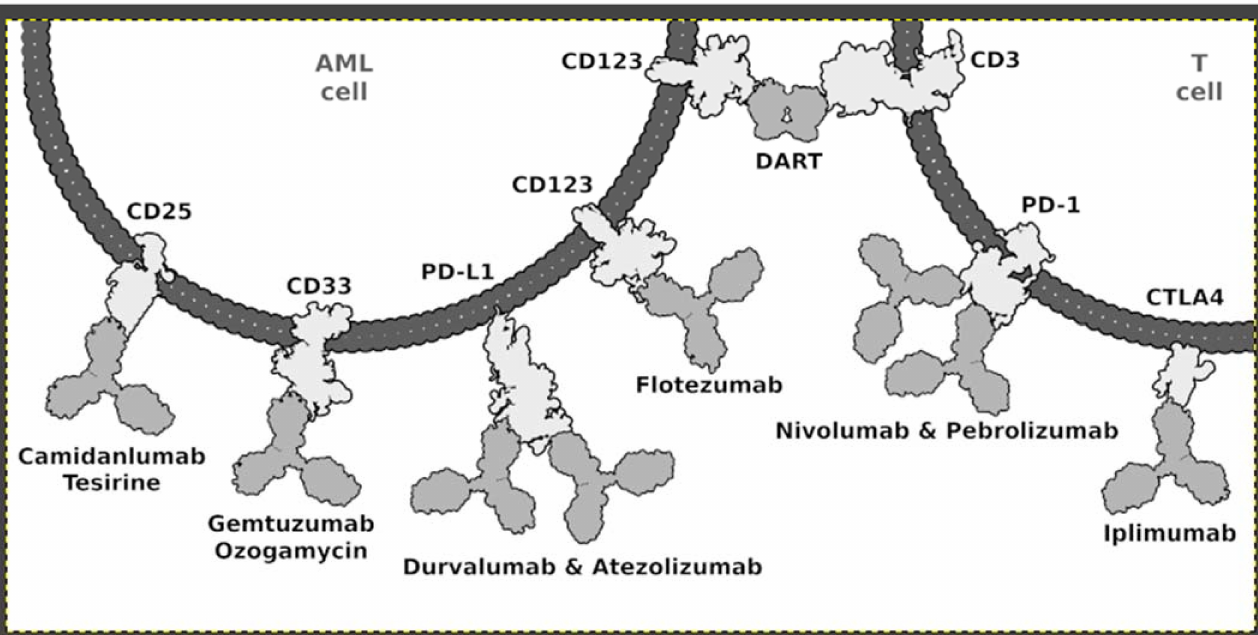
Figure 1. Monoclonal antibodies and their inhibitory targets on the surfaces of AML cells and T cells. Abbreviations: AML: acute myeloid leukemia; DART: dual-affinity